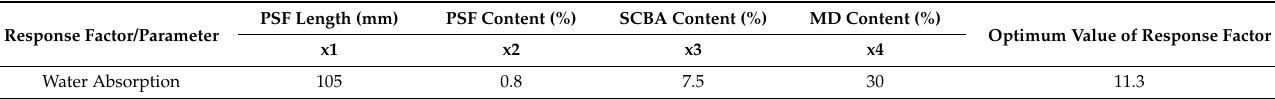
Table 5. Optimized value of the WA for various parameters at optimized conditions.